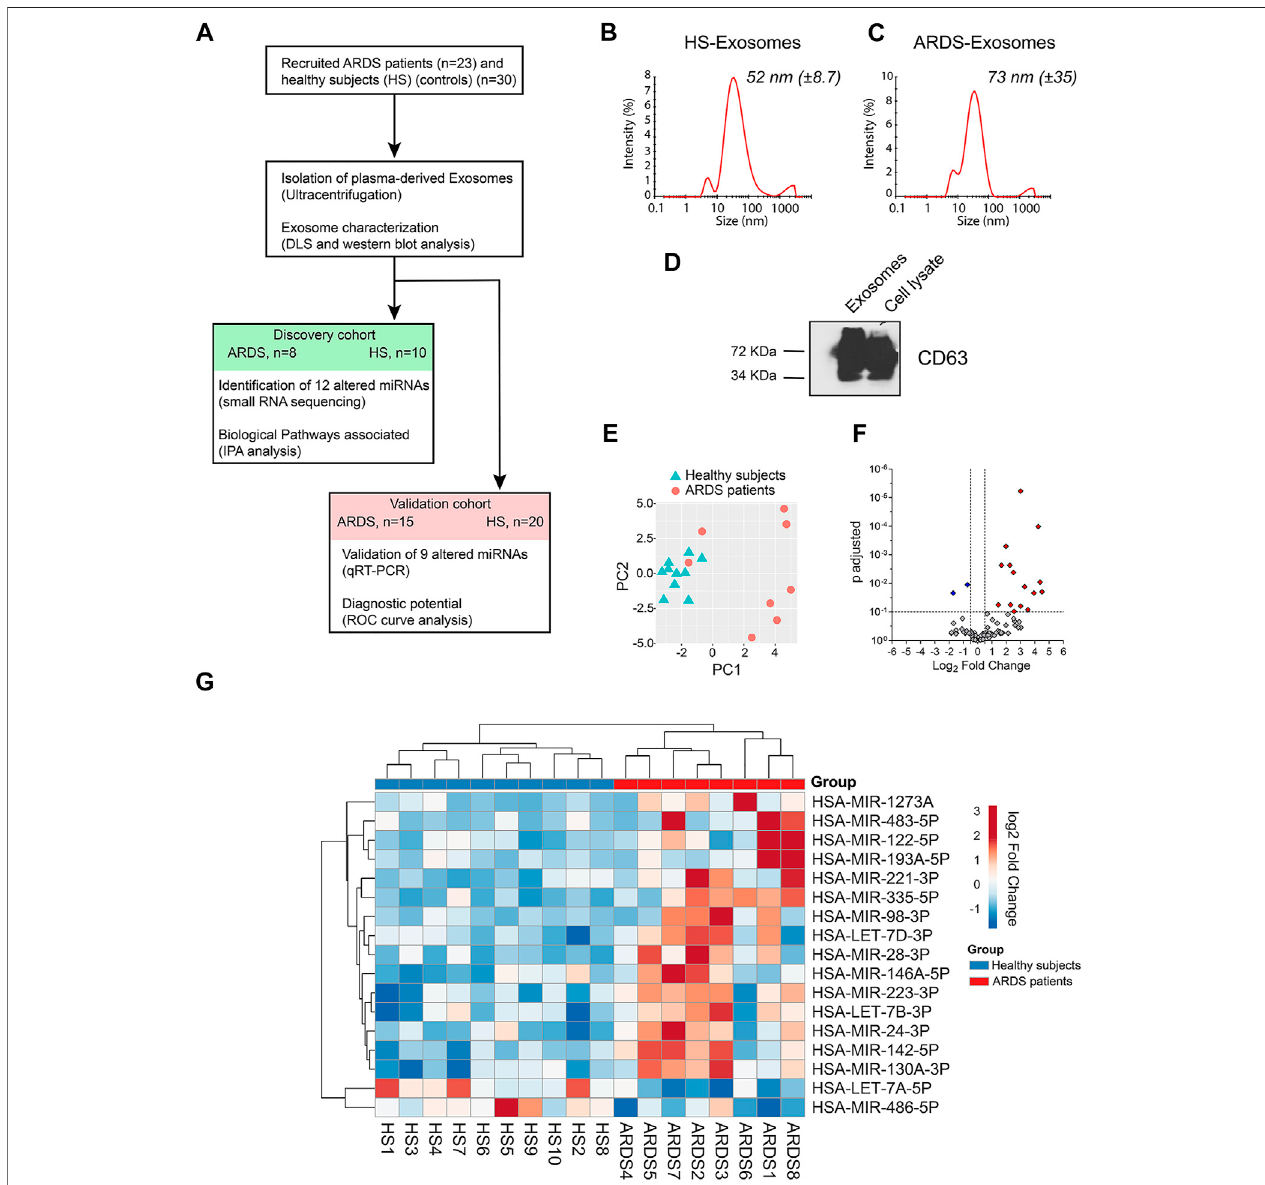
FIGURE1| Identi fi cationofexosomalmiRNAsalteredintheplasmaofARDSpatients. (A) Schematicrepresentationoftheapproachusedtoidentifythecandidate miRNA biomarker for ARDS. ARDS: acute respiratory distress syndrome, DLS: dynamic light scattering, HS: healthy subjects, IPA: Ingenuity Pathway Analysis, and ROC: receiver-operating characteristic. (B,C) Representative size distribution of exosome-like vesicles isolated from the plasma of (B) HSs and (C) ARDS patients by dynamic light scattering (DLS) analysis. (D) Western blot analysis of the exosomal marker CD63 in lysates from plasma-derived exosomes and cell lysate. (E) Principal component analysis (PCA) plot on miRNA expression data showing separation of exosome samples from HS and ARDS plasma. (F) Volcano plot showing the differentially expressed exosomal miRNAs. 17 miRNAs present differential expression between HSs and ARDS patients (fold change > 1.4 and adjusted p -value < 0.1). 15 upregulated (red) and 2downregulated (blue)miRNAs. (G) Heat map showing theexpression of17altered miRNAsin10 HSs(blue) and 8ARDS patients (red) within the discovery cohort after unsupervised two-way hierarchical